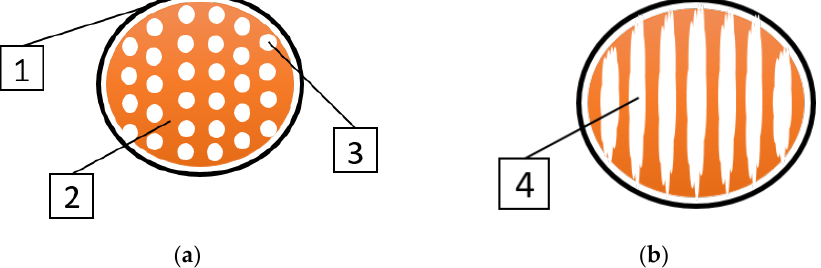
Figure 12. Structure of the biomass surface with artificial pores ( a ) and channels ( b ); 1 — crucible; 2 — biomass; 3 — artificial pores; 4 — artificial channels.